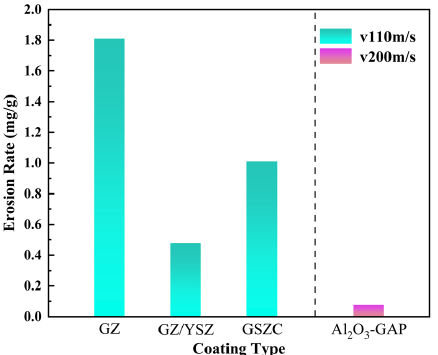
Figure 5. Erosion rates of four kinds of coatings [31].